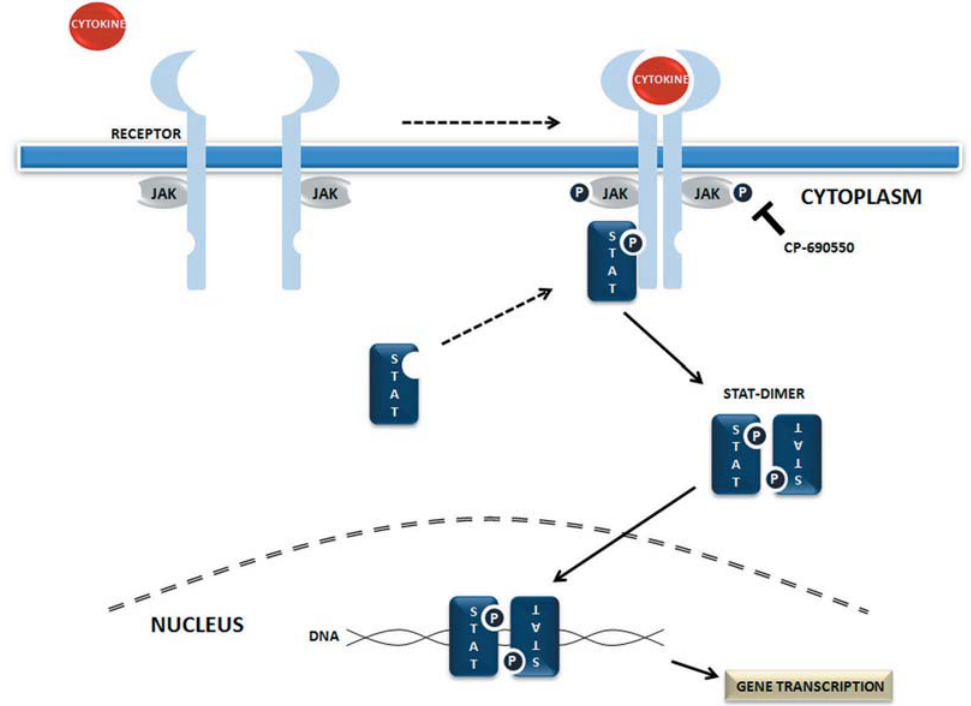
Figure 3- (cid:7){(cid:3)(cid:5)Q(cid:27)$(cid:3)$(cid:7)(cid:15)(cid:19)(cid:12)(cid:16)<(cid:19)(cid:18)(cid:30)(cid:7)(cid:12)(cid:16)(cid:9)(cid:7)(cid:19)(cid:21)(cid:12)(cid:13)(cid:28)(cid:19)(cid:12)(cid:13)(cid:17)(cid:14)(cid:7)(cid:17)(cid:20)(cid:7){(cid:19)(cid:14)(cid:10)(cid:6)(cid:7)(cid:12)(cid:18)(cid:8)(cid:17)(cid:6)(cid:13)(cid:14)(cid:9)(cid:7)>(cid:13)(cid:14)(cid:19)(cid:6)(cid:9)(cid:6)(cid:7)?{(cid:3)(cid:5)W(cid:7)(cid:19)(cid:20)(cid:12)(cid:9)(cid:8)(cid:7)(cid:21)(cid:18)(cid:12)(cid:17)>(cid:13)(cid:14)(cid:9)(cid:7)(cid:29)(cid:13)(cid:14)(cid:24)(cid:6)(cid:7)(cid:12)(cid:17)(cid:7)(cid:13)(cid:12)(cid:6)(cid:7)(cid:6)(cid:15)(cid:9)(cid:21)(cid:13)(cid:22)(cid:21)(cid:7)(cid:8)(cid:9)(cid:21)(cid:9)(cid:15)(cid:12)(cid:17)(cid:8)(cid:7)(cid:19)(cid:12)(cid:7) cell surface results in the phosphorylation of signal transducers and activators of transcription (STATs), which then dimerize and translocate to the nucleus where they can regulate gene transcription. The compound CP-690550 inhibits JAK3 and prevents activation of JAK/STAT